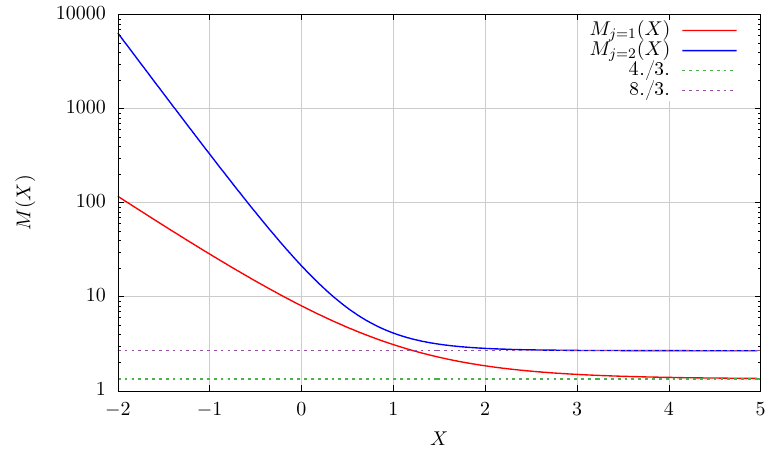
Figure 7 . Metric on the moduli space for the annihilating impurity with j = 1. The horizontal line denotes the asymptotic values M ( X = ). A logarithmic like scale is used for M , because M 1 grows very fast for negative X